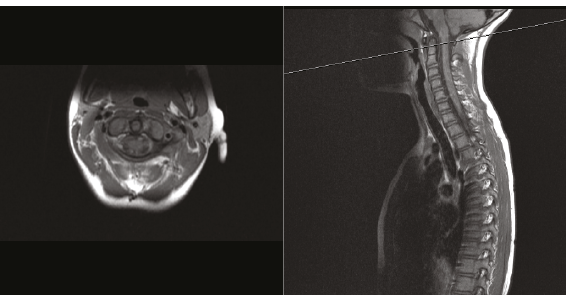
Figure 4: MRI of C-spine T2 stir